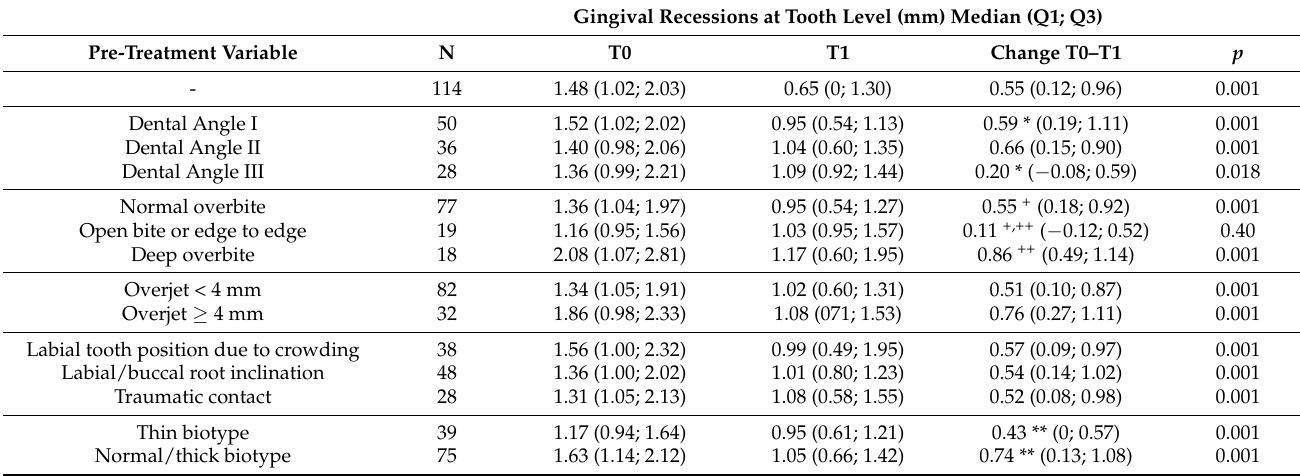
Figure 8. Median gingival recession change before and after orthodontic treatment in different groups of teeth. ◦ ,*- outliers. The percentage of improved GR was highest on maxillary canines (84.6%); however, the highest amount of GR improvement in millimeters was observed on maxillary and mandibular premolars ( p < 0.001). Healing of GR was mostly observed on maxillary incisors (46.7%). No recession was completely healed on mandibular incisors. Median GR change after OT at tooth level in relation to different pre-treatment factors could be seen in Table 3. Table 3. Pre-treatment variables and gingival recessions before (T0) and after (T1) orthodontic treatment and recession change T0–T1 at tooth